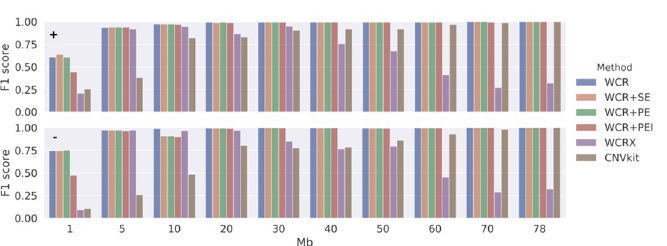
Fig 4. F1 performance in simulated data. F1 score (vertical axes) for simulated duplication (+, top panel) and deletion (-, bottom panel) events of varying sizes (1 to 78 Mb) at a fixed fetal fraction of 7.5% for the different methods using a 250 kb bin size.